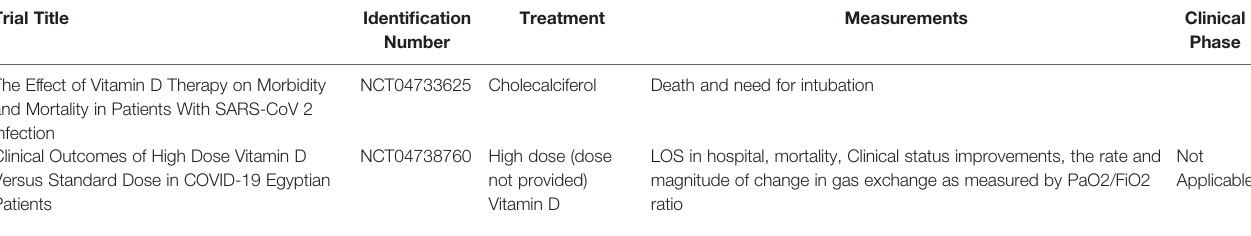
TABLE 4 | Current Vitamin D-relevant clinical trials in COVID-19 patients and their corresponding clinicaltrials.gov identi fi cation numbers, treatments, measured parameters, and clinical phases.